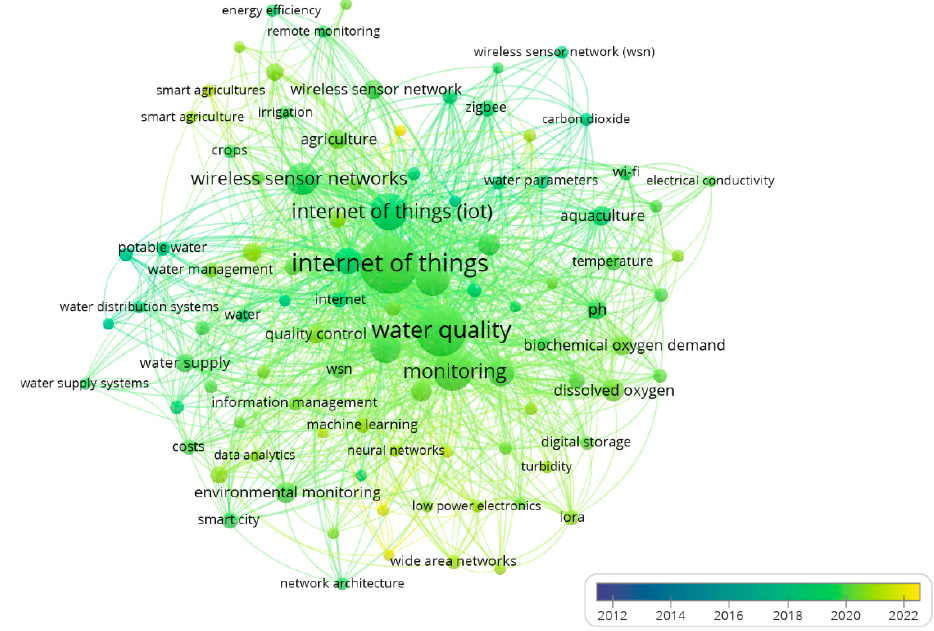
Figure 4. Timeline analysis of the published papers on IoT for water quality monitoring.